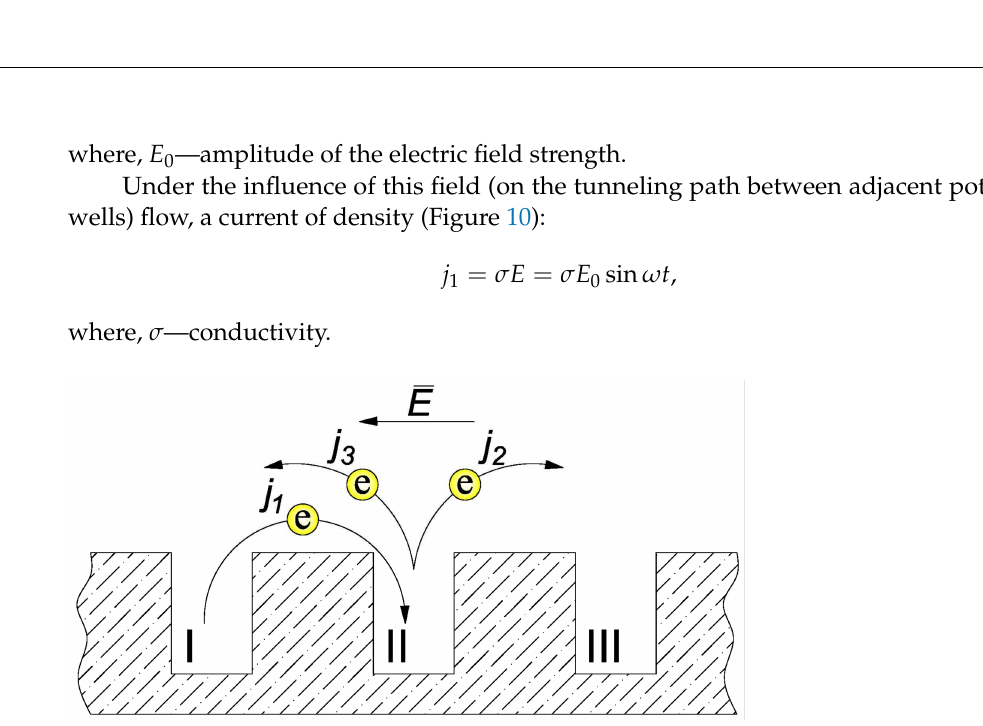
Figure 10. Potential wells and possible directions of electron tunneling: E —electric field, j 1 —current of density, j 2 —second component of the current density, j 3 —third component of current